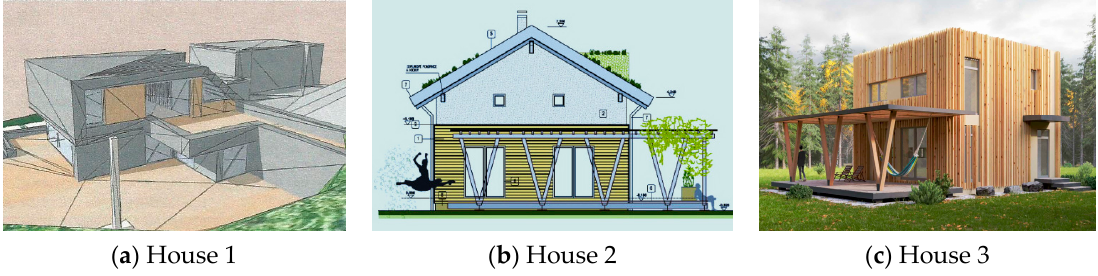
Figure 1. View of family